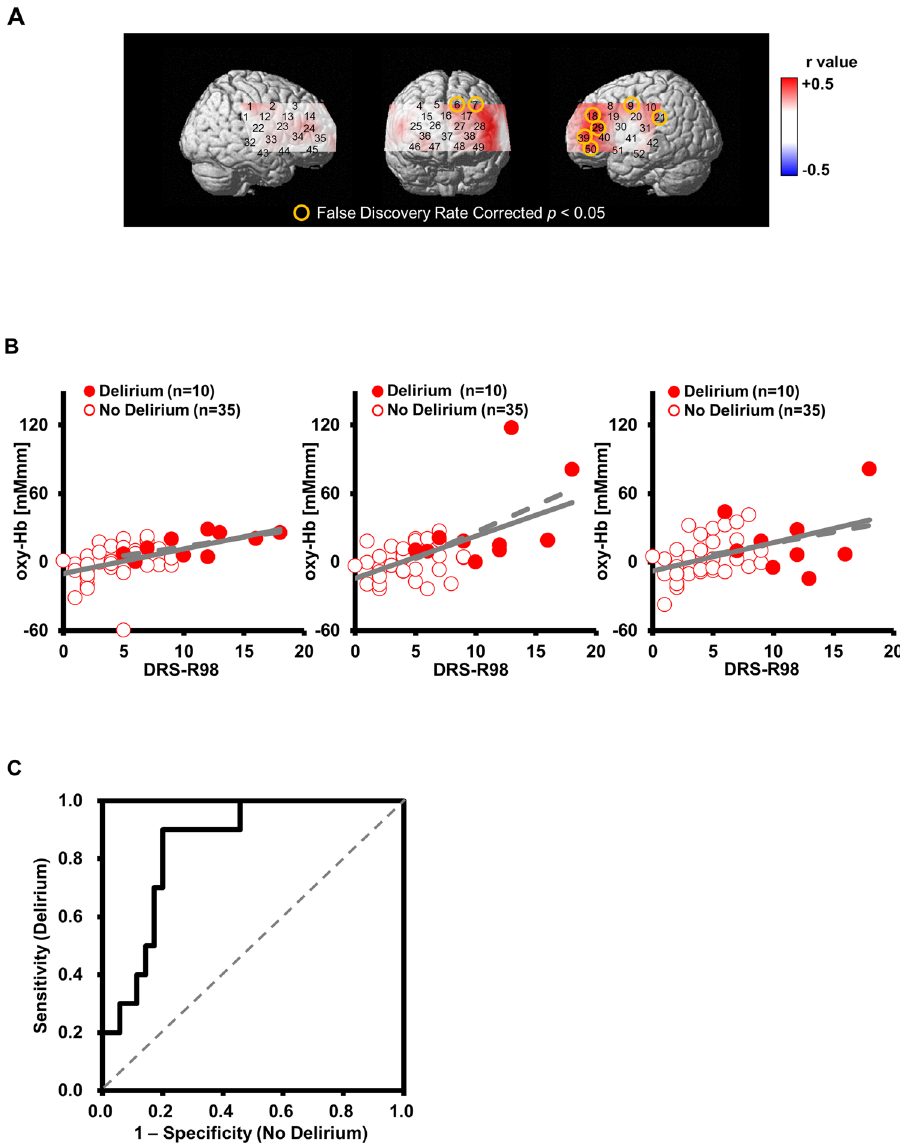
Figure 4. Relationship between severity of delirium measured with the Delirium Rating Scale-Revised 98 (DRS-R98) and oxygenated hemoglobin ([oxy-Hb]) integral value during the sustained attention task (SAT) in delirious and non-delirious patients with end stage liver disease (ESLD) (N = 45). ( A ) The 3D topographic maps indicate Pearson’s r values between [oxy-Hb] integral value and DRS-R98 severity scores in patients with ESLD (yellow circles: p < 0.05 false discovery rate corrected). ( B ) The scatter plots indicate correlations between [oxy-Hb] integral value and DRS-R98 severity scores in channel 18, left middle frontal gyrus (left) (Pearson’s r = 0.527, p < 0.001); channel 29, left inferior frontal gyrus (middle) (Pearson’s r = 0.600, p < 0.001); and channel 39, left inferior frontal gyrus (right) (Pearson’s r = 0.477, p = 0.001). Dotted lines are trend lines of patients with delirium. Solid lines are trend lines of all patients. ( C ) The Receiver Operating Characteristics indicate discrimination of patients with delirium from those with no delirium using mean [oxy-Hb] integral value in channel 18, 29, and 39. The area under the curve is